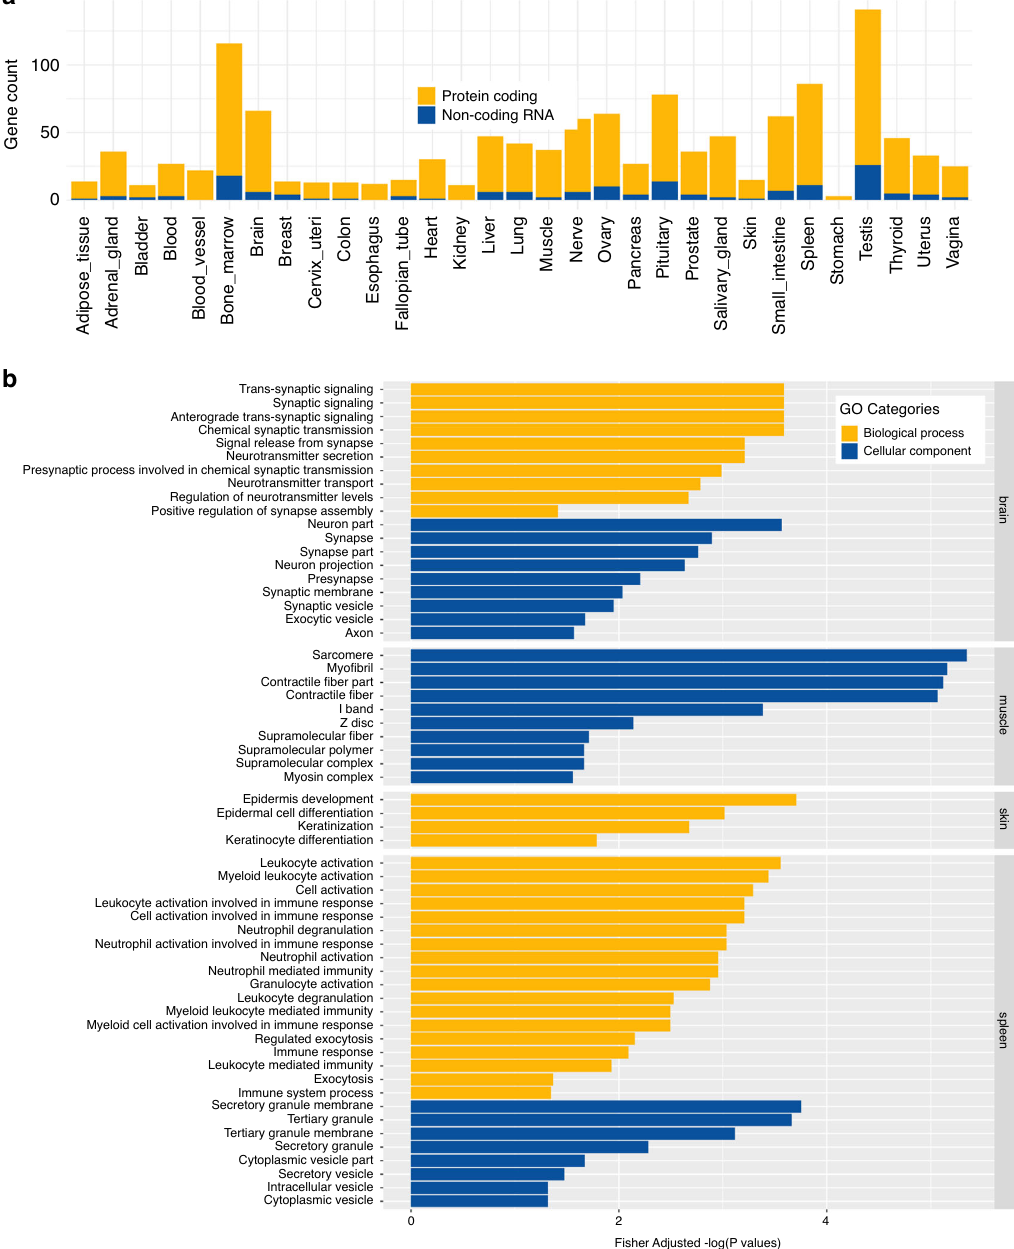
Fig. 4 GTEx RNA-Seq analysis using previously unmapped reads. a Barplot showing the total number of tissue-speci fi c expressed genes across 31 different histological sites. Yellow — protein-coding genes; blue — non-coding RNA. b Top gene ontology terms in four different histological